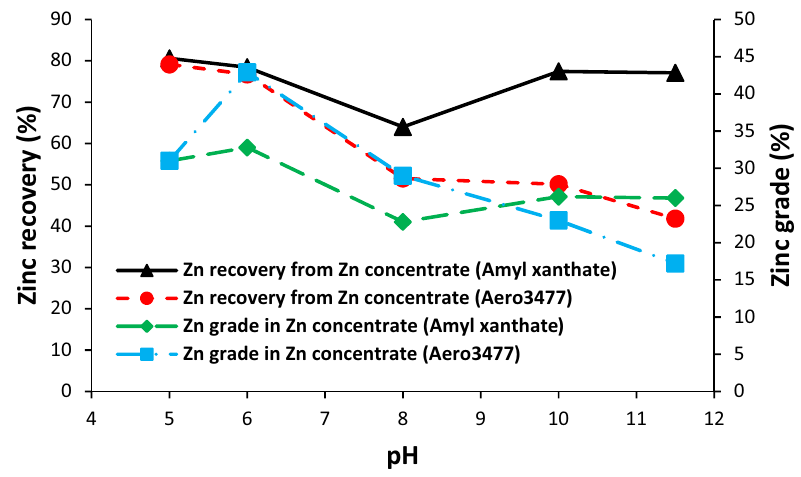
Figure 8. Effect of pH and collector type on zinc recovery and grade in the zinc concentrate.